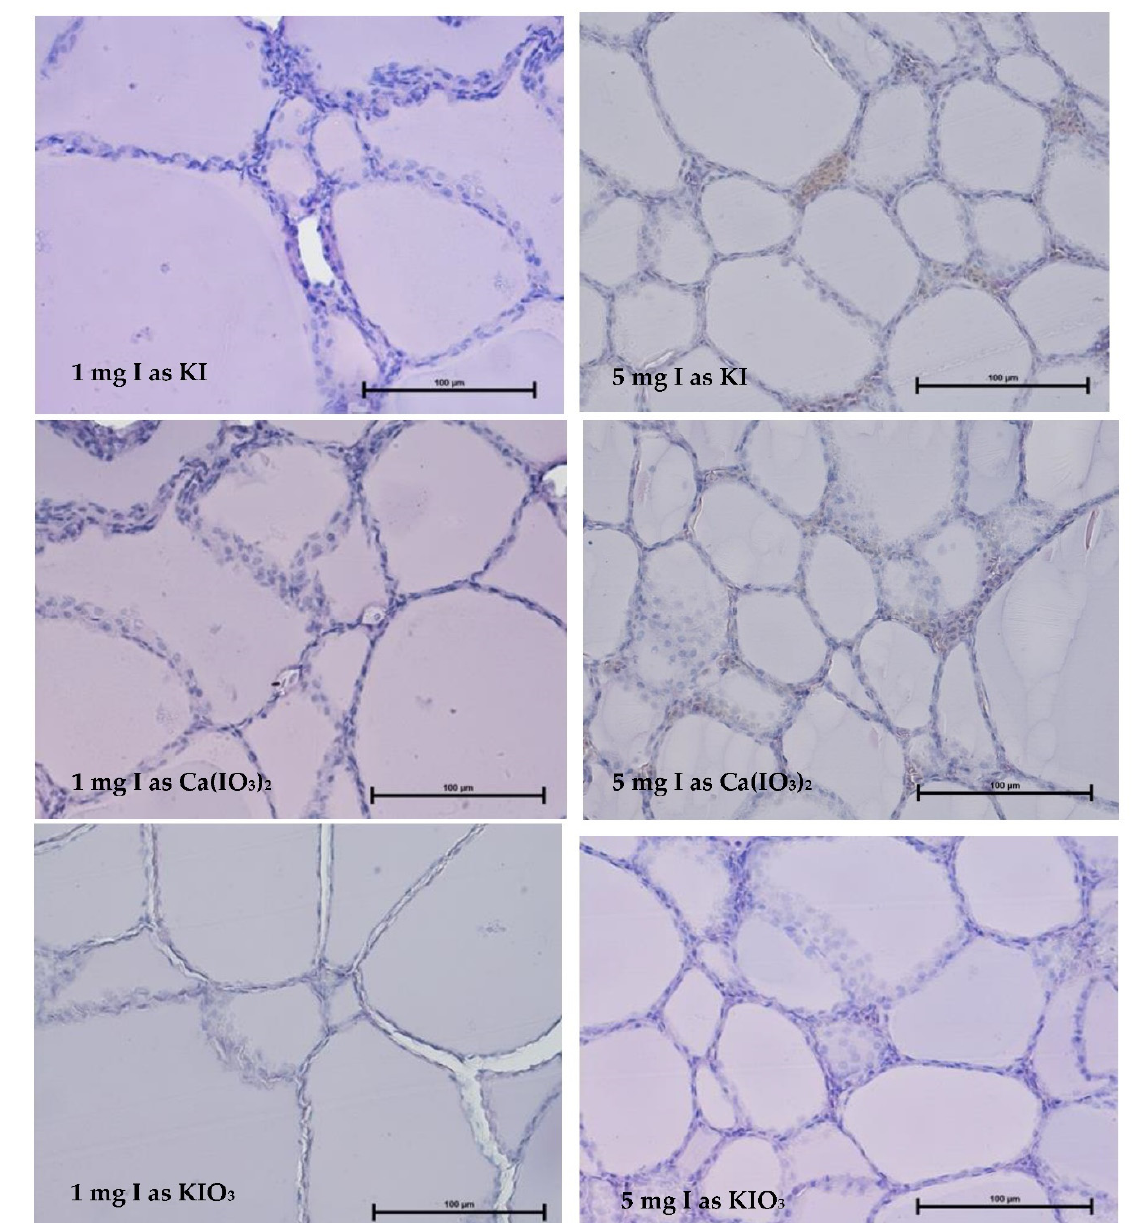
Figure 1. Representative pictures of the thyroid gland from the birds fed with diets of different iodine supplements and levels (HiE Mag 400) (Experiment I).